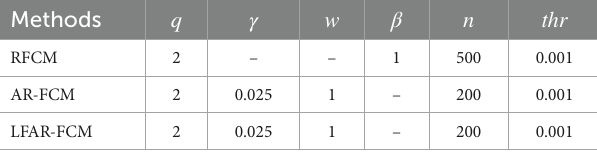
TABLE 2 Parameter settings for RFCM, AR-FCM and LFA-FCM methods.